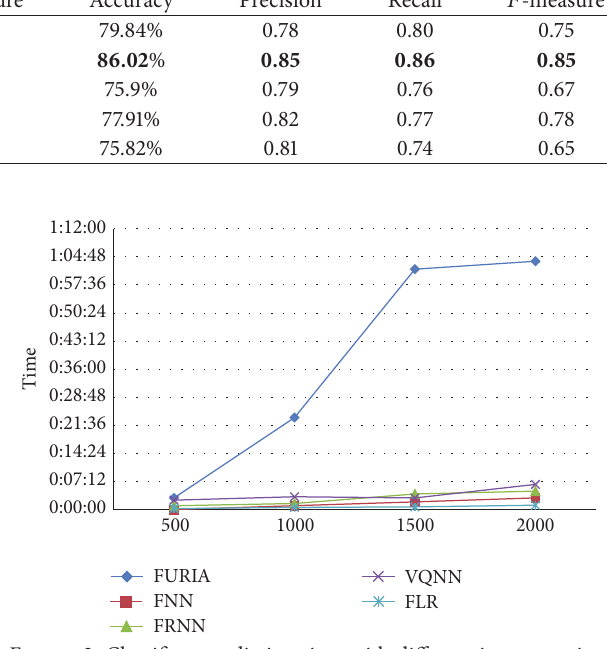
Figure 2: Classifiers prediction time with different instances sizes on restaurants